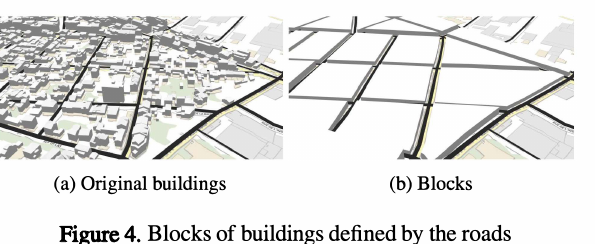
Figure 4. Blocks of buildings defined by the